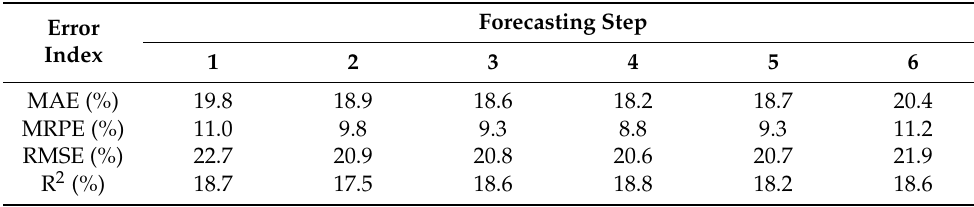
Table 4. Accuracy improvement of the ARIMA model.